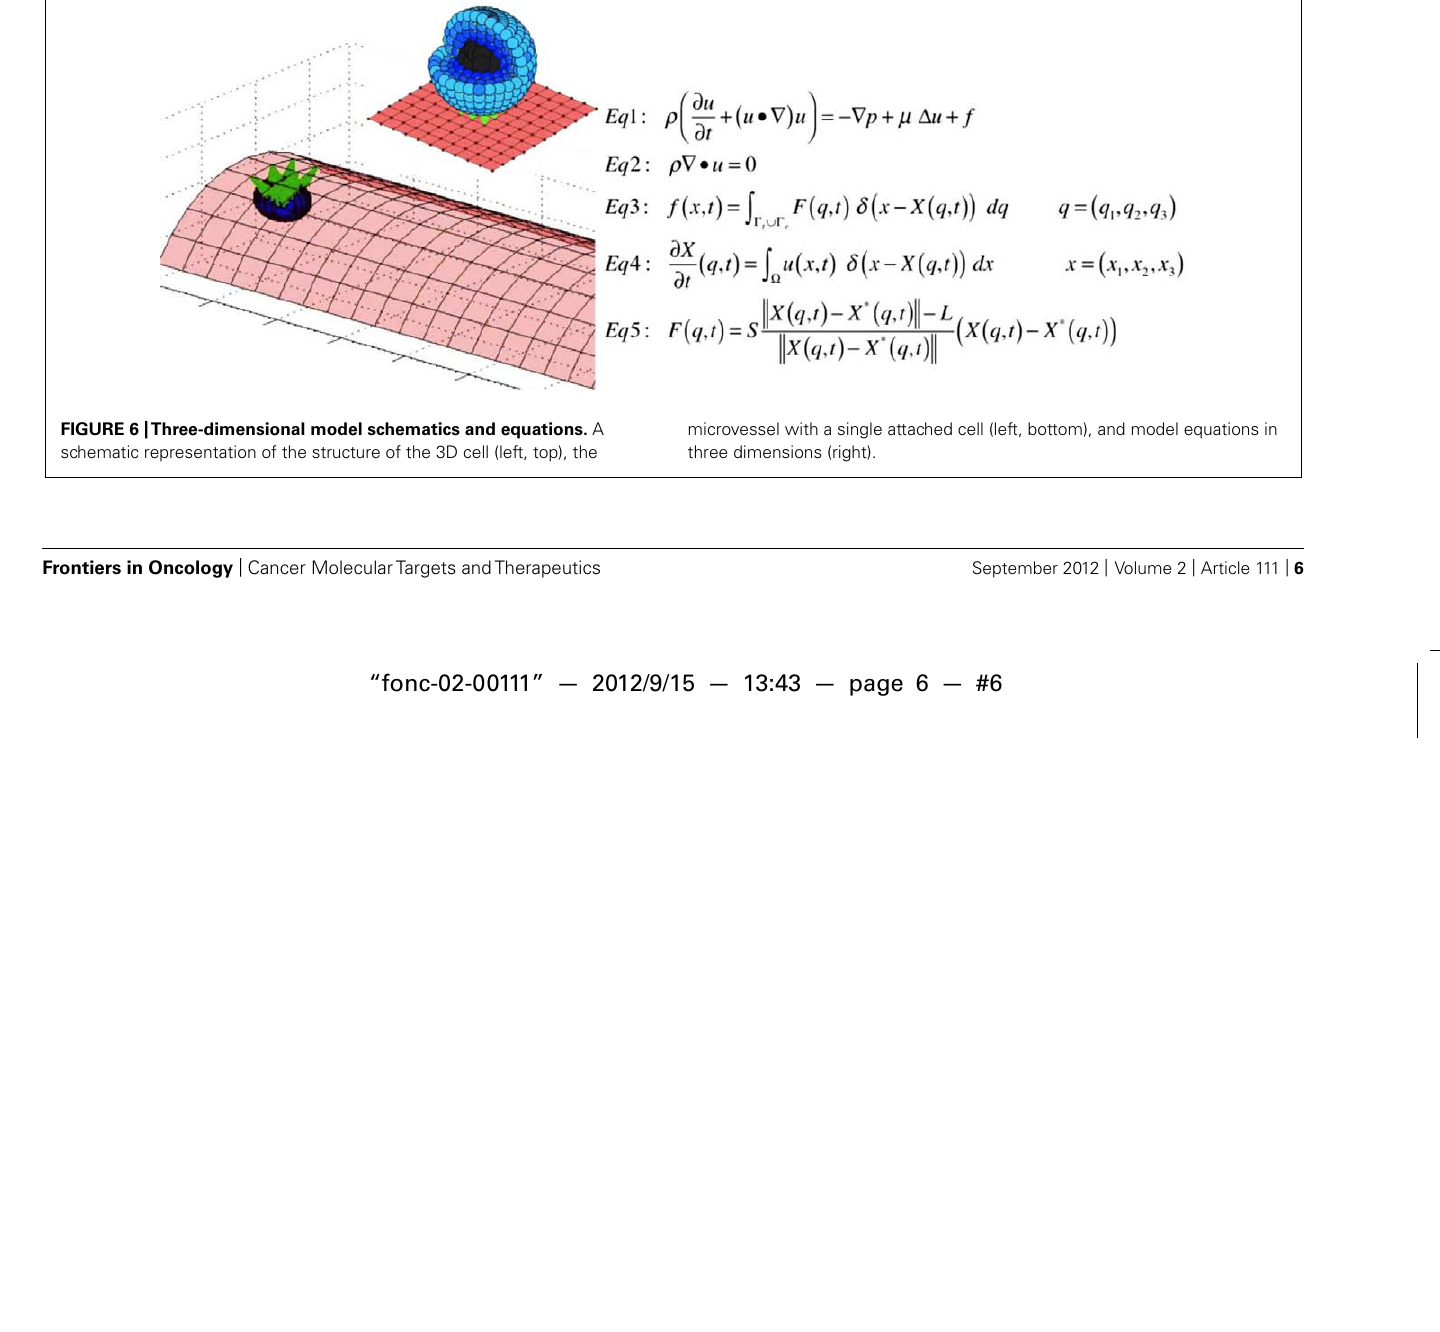
microvessel with a single attached cell (left, bottom), and model equations in three dimensions (right).